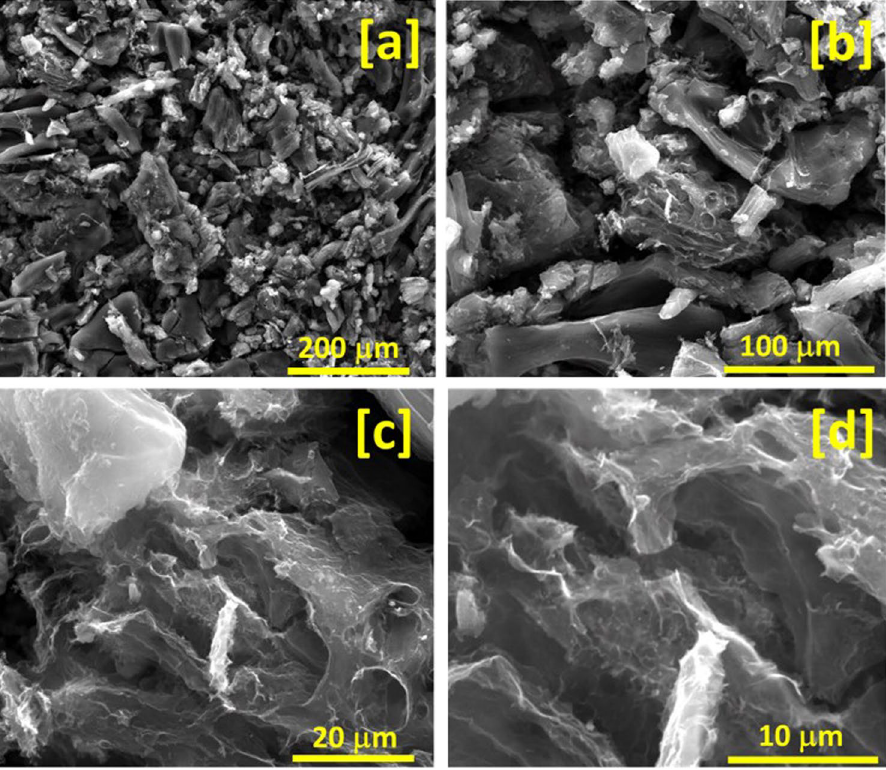
Figure 3. SEM images of the carbonized jute at various